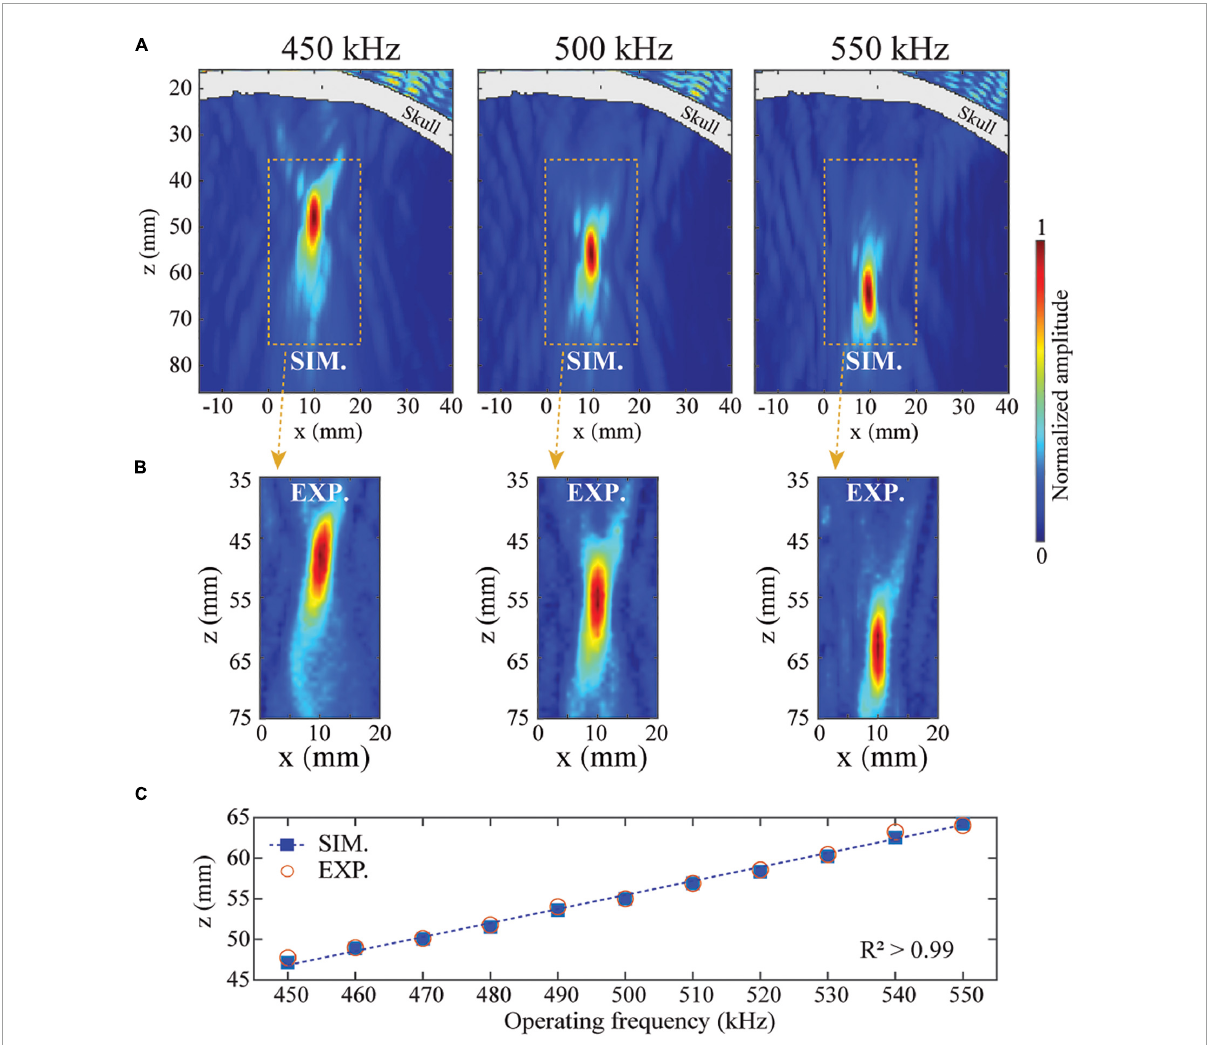
FIGURE4 Dynamic steering of the tFUS focus. The transcranial focusing depth of BAM was electronically steered by changing the operating frequency of the ultrasound transducer. (A,B) Simulated and experimentally measured ultrasound fields in the xz-plane at 450, 500, and 550 kHz, respectively. (C) Simulated (solid squares) and experimentally measured (open circles) focal depths from 450 to 550